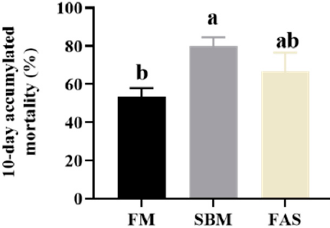
Figure 6. Ten-day accumulated mortality in Vibrio harveyi challenge test of Japanese seabass fed